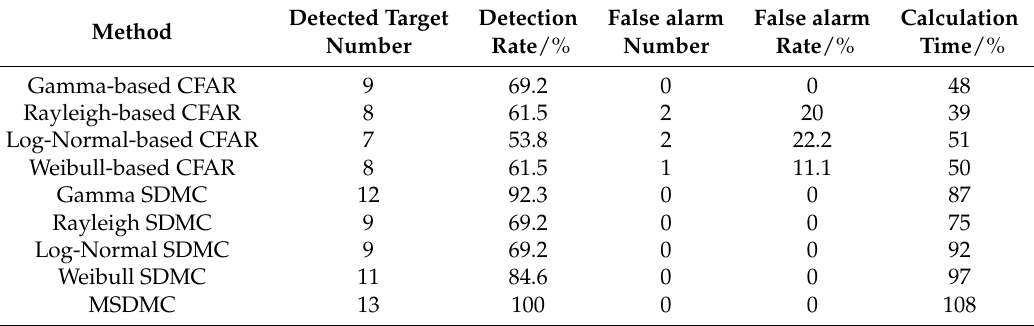
Table 4. Accuracies of target-detection results in the Davis–Monthan data set using different methods.